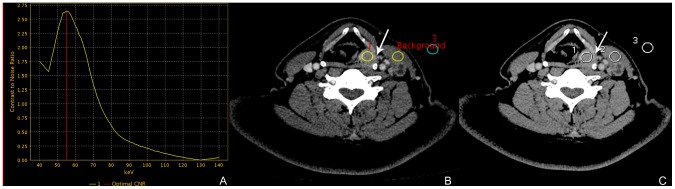
Enhanced axial images in venous phase from a 58-year-old patient with supraglottic SCC, for objective evaluation of image quality.A, B and C are the optimal CNR curve, 55(A) Demonstrating the GSI Viewer calculation of the CNR curve, optimal monochromatic energy of 55 keV achieved the best CNR for the primary lesion, and the locations of the background ipsilateral sternocleidomastoideus (RIObackground) and primary lesion (RIO1) to generate the curve on (B). The air region (RIO3) is evaluated as the index of image noise. (C) The size, shape and position of the ROIs are kept consistent with image (B), and the primary lesion is less visible than that on the monochromatic image at 55 keV (arrow). On image (B), contrast: 32.16, noise: 7.83, CNR: 4.11; on image (C), contrast: 16.23, noise: 7.02, CNR: 2.31.